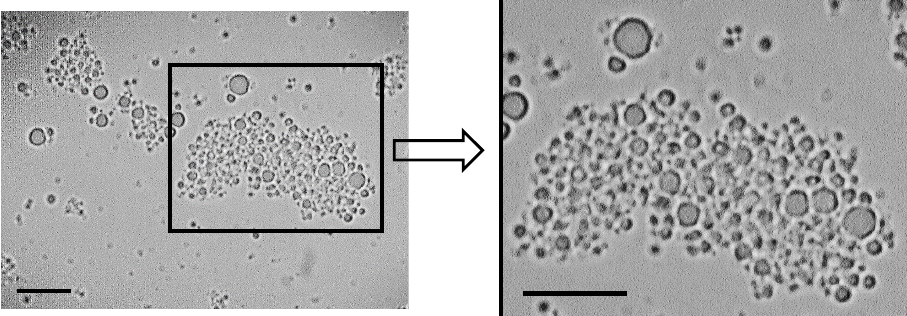
Figure 4. Micrographs (100×) of IMF powder emulsions, reconstituted in water ( A ) and 1% SDS ( B ). Black bars represent 50 µm.